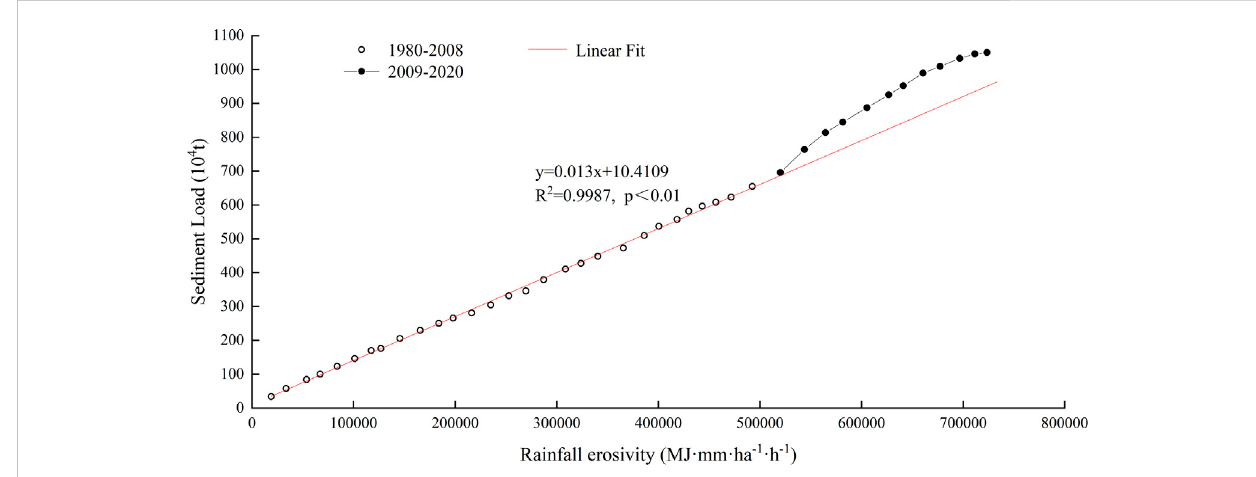
Double accumulation curve analysis between the sediment load and rainfall erosivity in the Nandu River Basin.